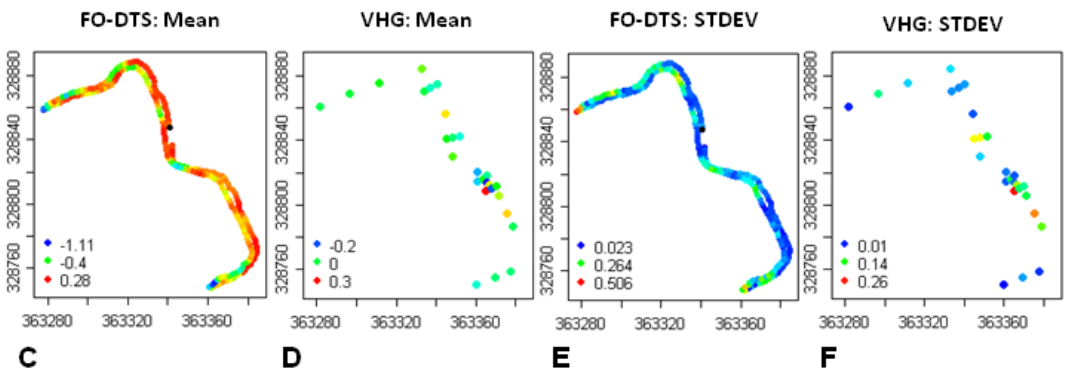
Fig. 9. Comparison of the temporal mean and standard deviation of signal strength for FO-DTS A T ( x i ) (A) and VHG A VHG ( x i ) (B) . Red symbols indicate piezometers at locations with low conductivity flow confining streambed sediments; maps of the temporal mean of A T ( x i ) and A VHG ( x i ) for the FO-DTS and the VHG observations (C, D) and maps of the corresponding standard deviations of A T ( x i ) and A VHG ( x i ) over all sampling dates (E, F)